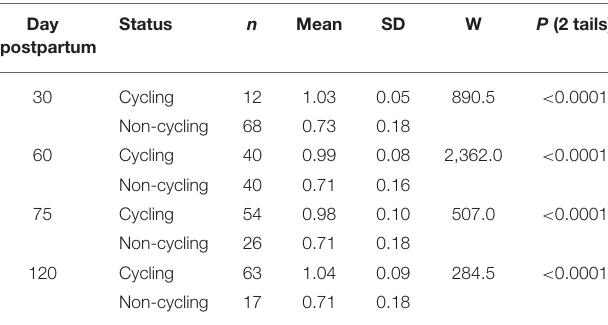
TABLE 1 | Comparison of backfat thickness between cycling and non-cycling cows at different days